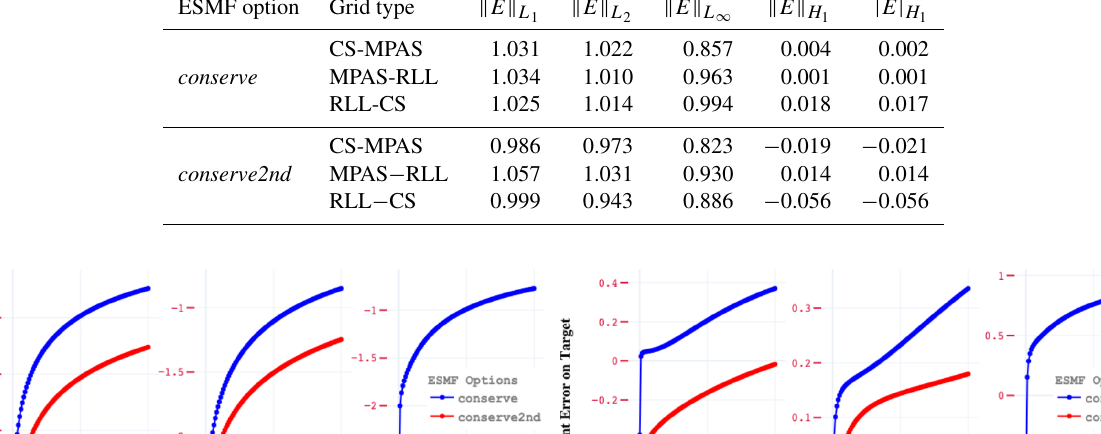
) (a) and log( (cid:107) E (cid:107) H ) (b) global error metrics as a function of N r . 2 1